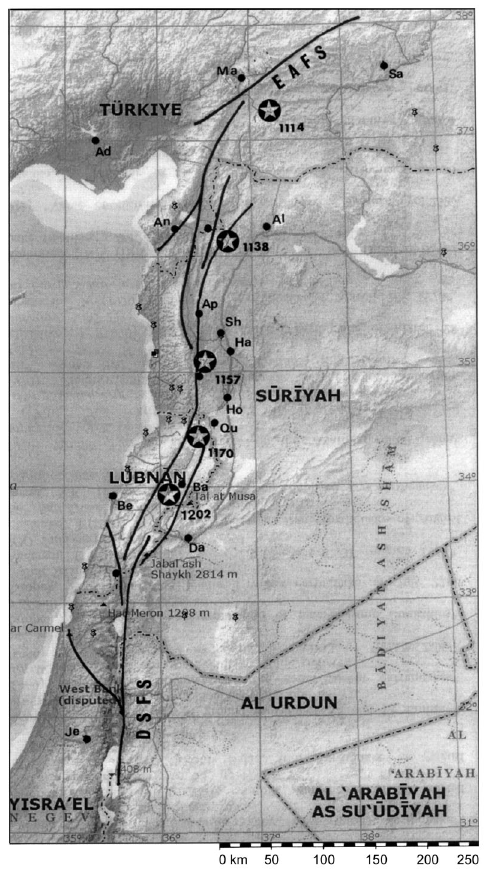
Fig. 1. The dominant tectonic feature of the Levant. DSFS – Dead Sea fault system; EAFS – East Anato- lian fault zone. Open stars show the general location of the epicentral region of the earthquakes investigat- ed. The location of the 1202 earthquake comes from a separate study (Ambraseys and Melville,